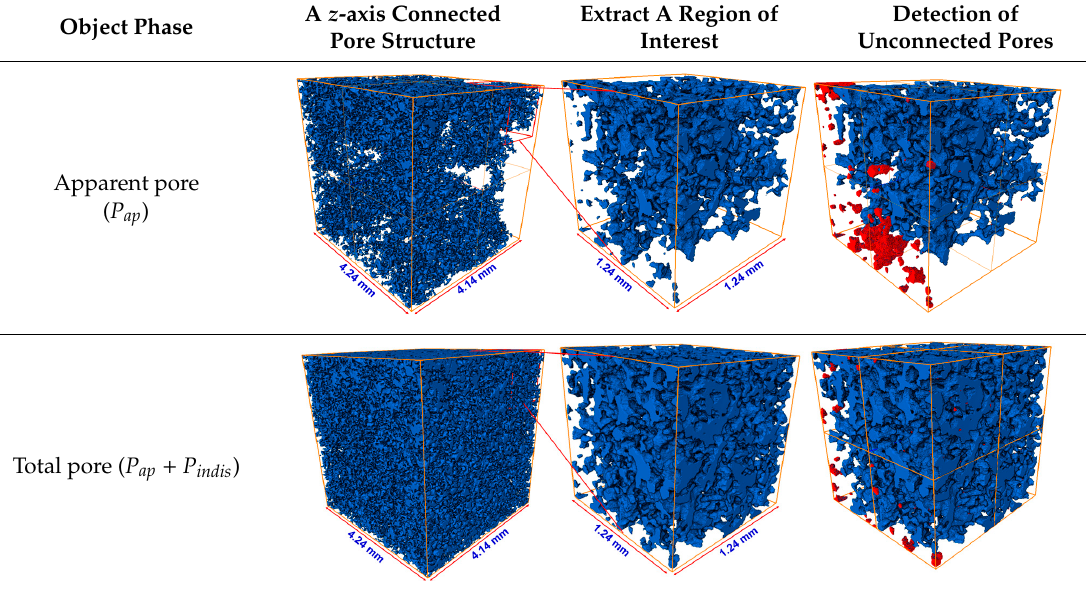
Figure 8. Computed velocity and pressure gradient field dependent on the pore structure in region of interest configured as ( a ) the P ap phase or ( b ) the P ap + P indis phase for Berea sandstone. Table 11. Variability of connected pore structure domain according to criteria determining which phases to include in the pore space of Berea sandstone. After a region of interest was extracted with a size of 201~301 tetrahedral voxels, unconnected pores at each domain were designated as negligible regions. Object Phase